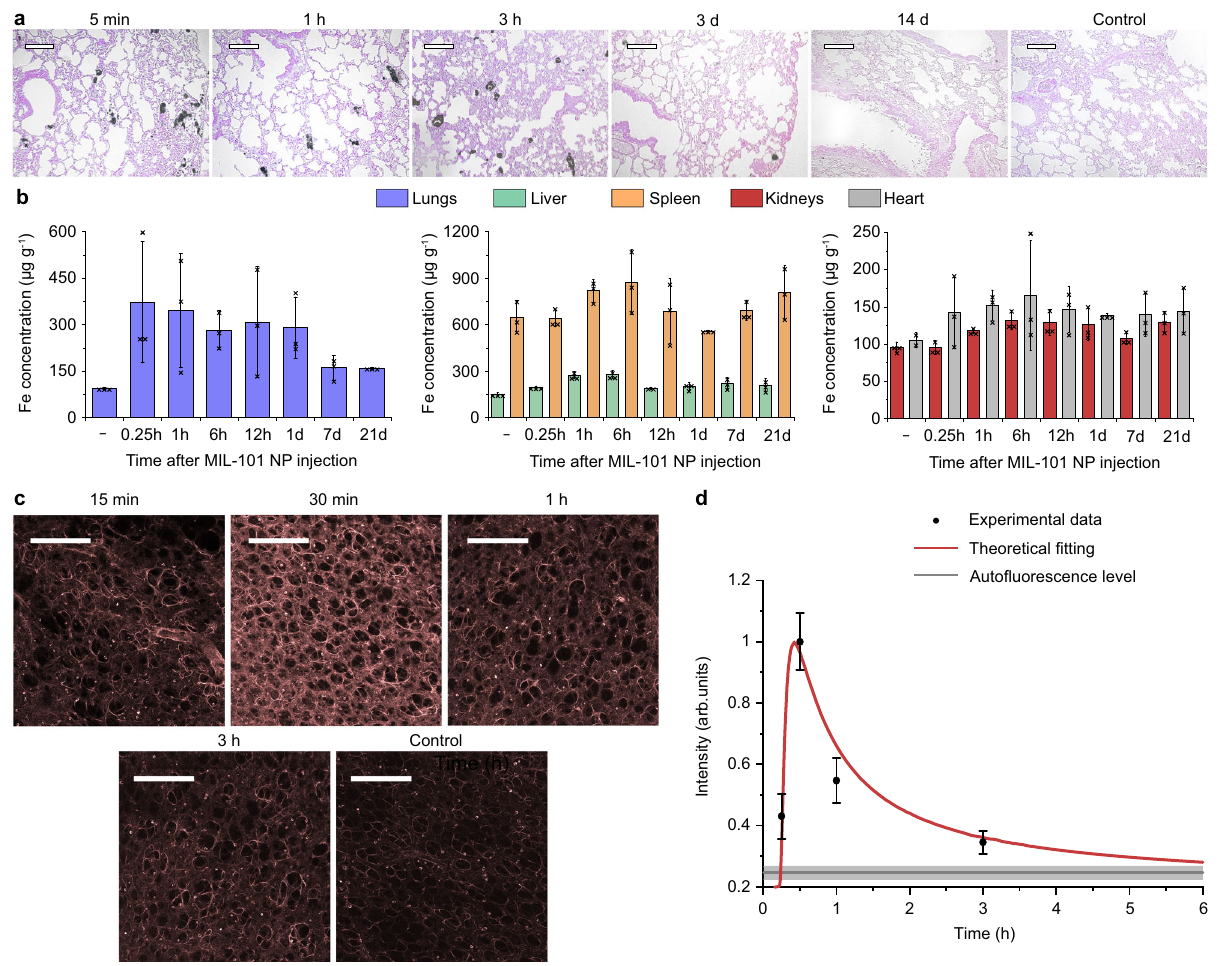
Fig. 5 | Investigation of the drug delivery to the lungs using MIL-101 nano- particles. a Histological evaluation of the lung tissue at several time points, fol- lowing the MIL-101 NP injection. The tissue sliceswere stained with eosinand Perls Prussianblue. n =3mice.Scalebars=50 µ m. b Evaluationoftheironconcentration in the main organs afterthe MIL-101NPinjection:lungs(blue),liver(green),spleen (orange), kidneys (red), heart (grey). n =3 mice. c Representative confocal images